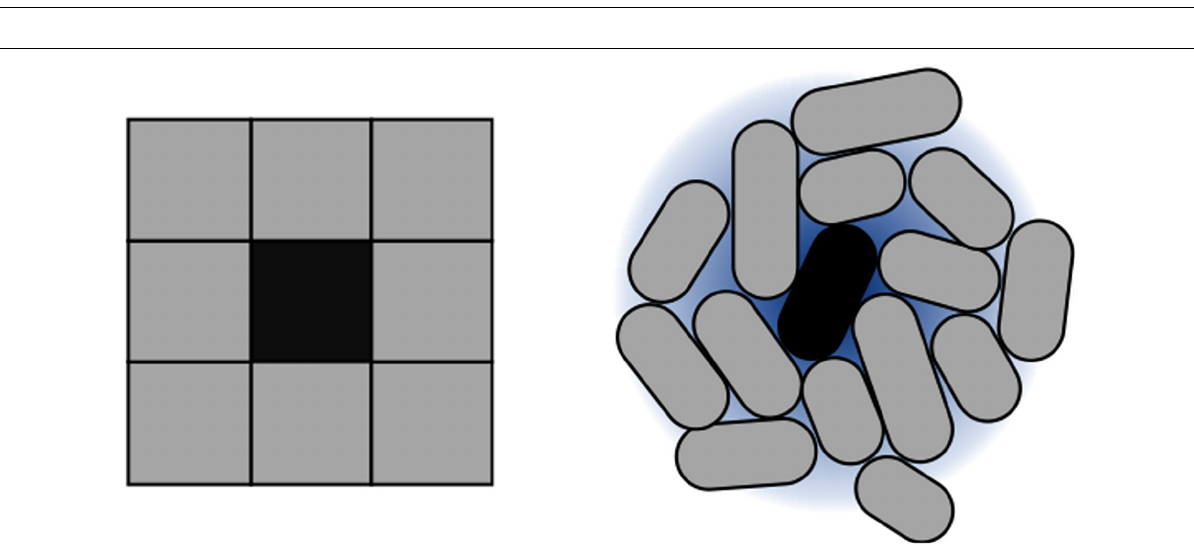
Frontiers in Bioengineering and Biotechnology |